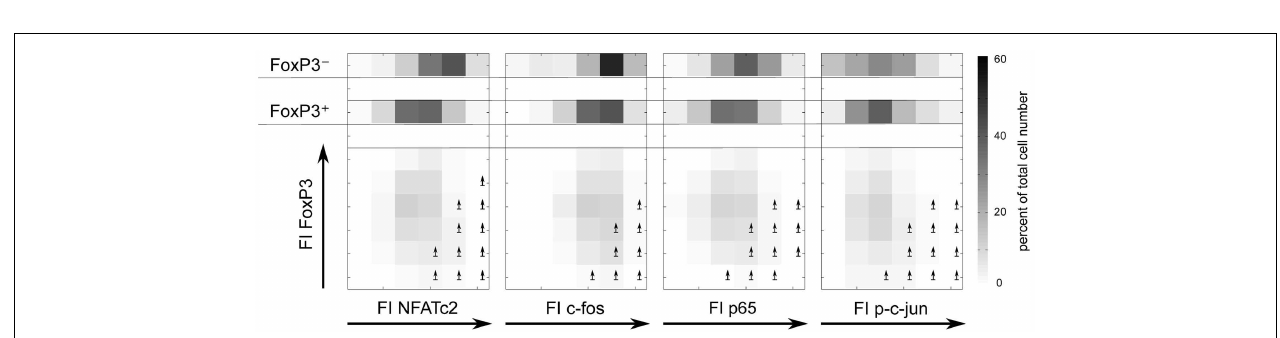
FIGURE 4 | Negative correlation of FOXP3 and positive correlation of NFATc2, c-Fos, NF- κ Bp65, and c-Jun expression level with IL-2 expression within the FOXP3 + population. Sorted human CD4 + CD45RO + T cells were stimulated with PMA/ionomycin for 5h, fixed and stained with fluorophore-coupled antibodies against FOXP3, intracellular IL-2 and in parallel with one of the transcription factors NFATc2, c-Fos, NF- κ Bp65, or p-c-Jun. Data from the gated FOXP3 + cell population were transformed into a linear